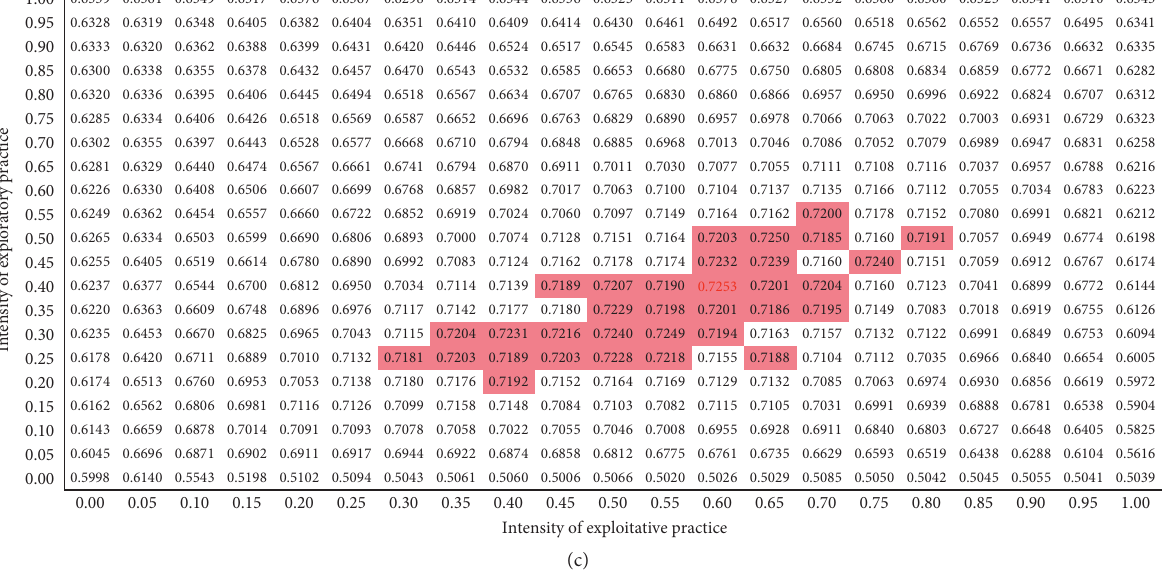
� 0.005. (b) p � 0.01. (c) p � 4 4 4